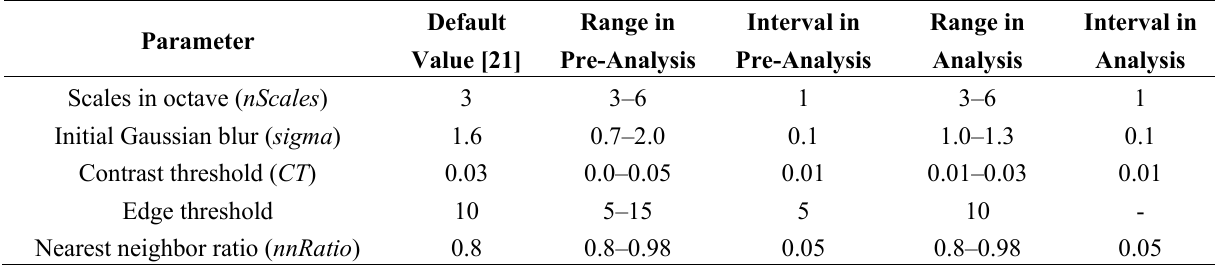
Table 2. SIFT parameters considered in the